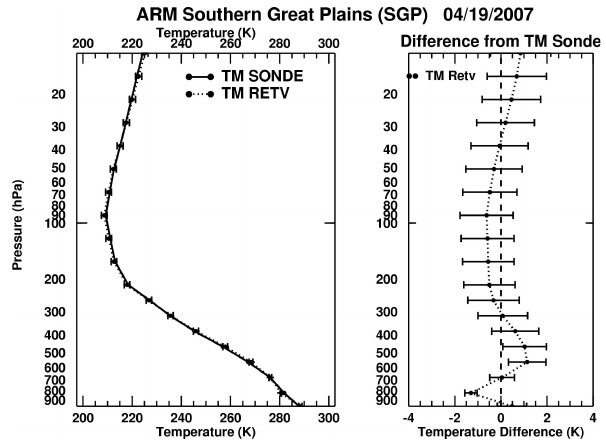
Fig. 9. Comparison plot of the sonde (a priori) and the retrieved temperature profiles for the land case over the ARM SGP site.